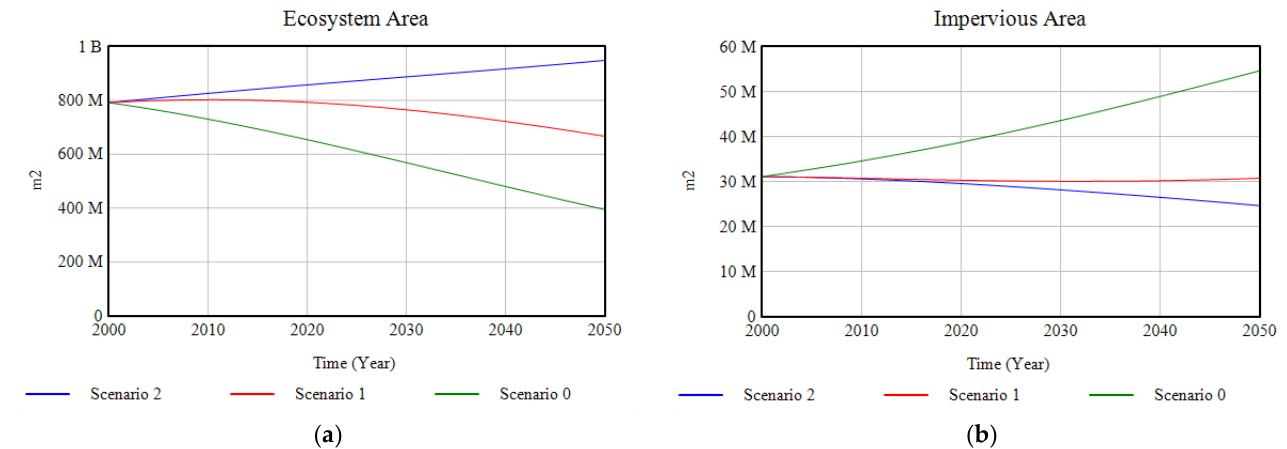
Figure 10. ( a ) Results of the modelling of the ecosystem area for the three scenarios; ( b ) results of the modelling of the imperious area for the three scenarios, in the period 2000–2050.